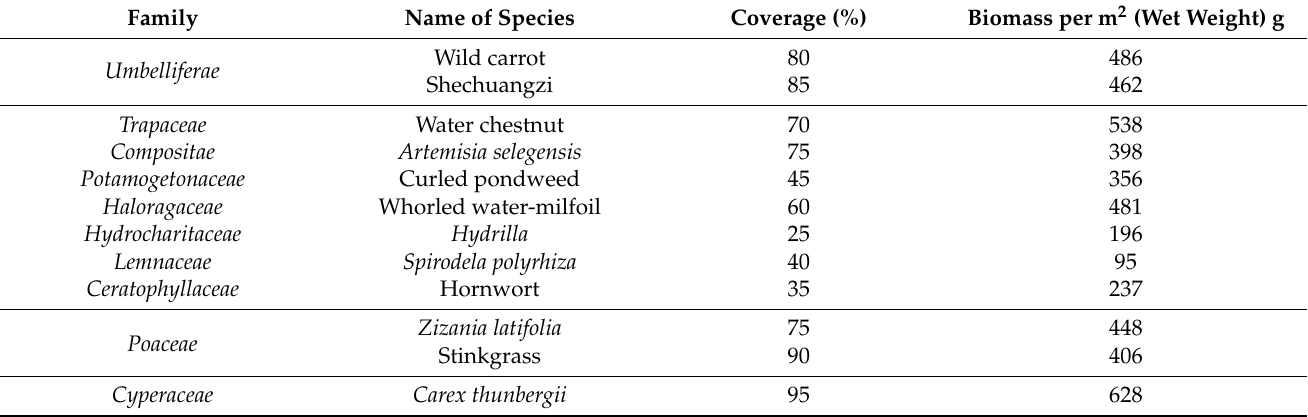
Table 2. Species, coverage, and biomass of higher aquatic vascular plants in Shengjin